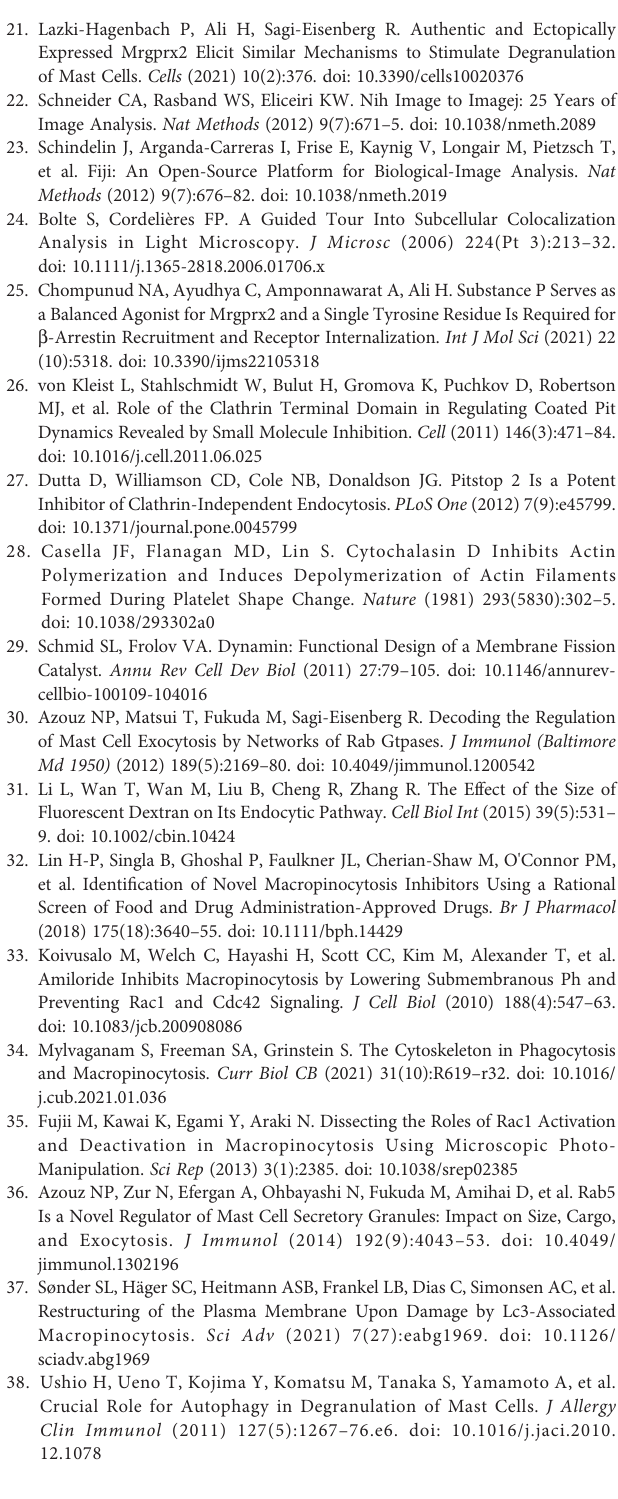
(STX3) antibodies, followed by Alexa Fluor® 647-conjugated goat anti-mouse secondary antibodies (pseudo colored cyan) and Alexa Fluor® 488-conjugated goat anti-rabbit secondary antibodies (pseudo colored red). Enlargements correspond to the boxed areas. Enlargements correspond to the boxed areas.